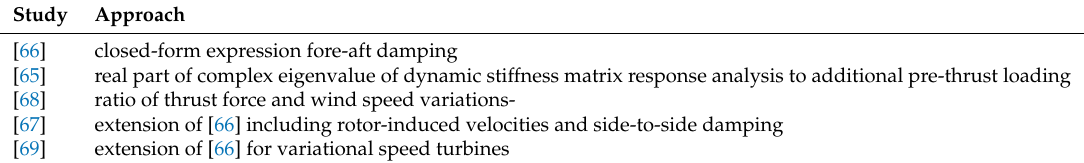
Table 1. Overview of studies presenting approaches to estimate the aerodynamic damping of an operating wind